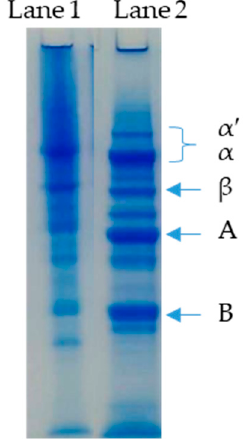
Figure A1. Sodium dodecylsulphate polyacrylamide gel electrophoresis (SDS-PAGE) profile of soy protein isolate obtained under non-reducing (lane 1) and reducing (lane 2) conditions.